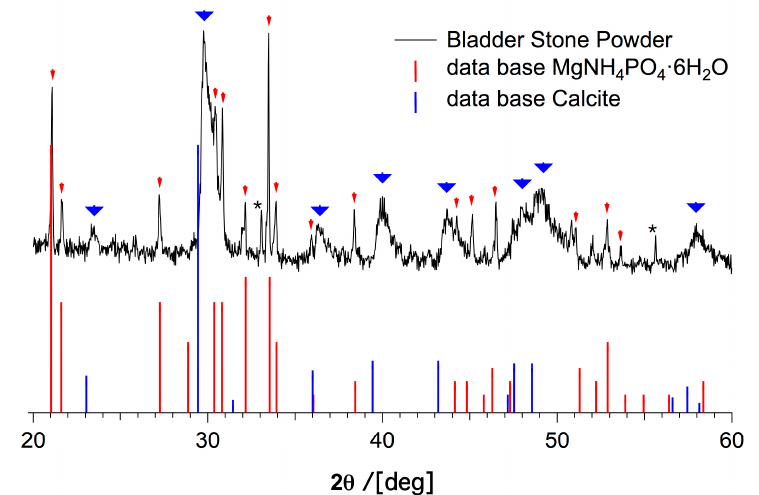
Figure 3. Top trace: X-ray diffractogram of the powdered urinary stone. Bottom lines: literature diffractograms for magnesium ammonium phosphate (struvite, MgNH 4 PO 4 ∙ 6H 2 O) ( red ) and calcite ( blue ). The asterisks (*) label reflections that cannot be unambiguously